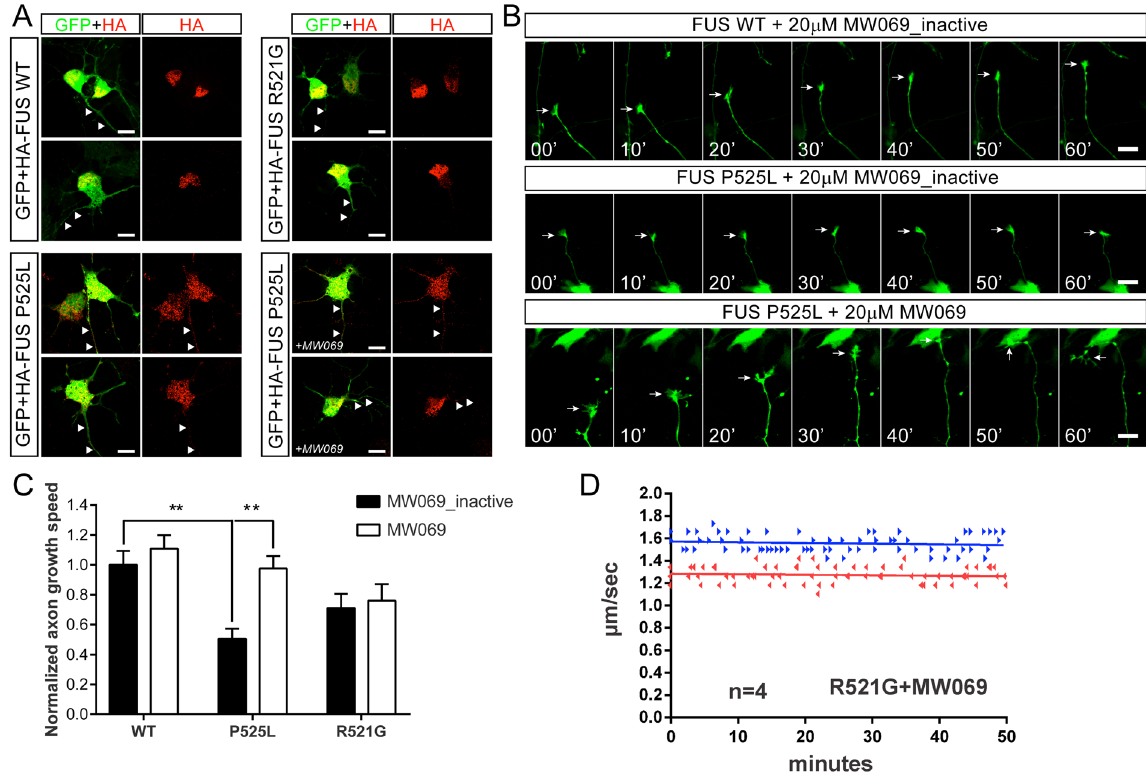
Figure 4. Mutant FUS impairs axon outgrowth in motor neurons through a mechanism involving p38 MAPK activity. Murine motor neurons were transiently co-transfected with FLAGHA-FUS WT, R521G or P525L and green fluorescent protein (GFP) at 2 days in vitro (DIV). Motor neurons were cultured in 20 μ M MW069, a potent and selective p38 MAPK inhibitor, or an inactive analogue, MW069_inactive. ( A ) FUS WT and R521G are predominately expressed within the nucleus of motor neurons, where as FUS P525L is expressed in the nucleus and within axons (white arrowheads). FUS P525L localization is similar whether motor neurons are treated with MW069_inactive or MW069 ( + MW069). ( B ) Montages corresponding to live cell imaging of axon outgrowth (white arrow) over a 60 min time course for the indicated condition. Note that the growth cone of a FUS P525L expressing motor neuron is stalled in the presence of MW069_inactive (middle panel) relative to the active form of MW069 (bottom panel). See Supplemental Video S1 for live cell imaging of all conditions. ( C ) Quantification of axon outgrowth speed compiled from n = 3 biological experiments normalized to the WT + MW069_inactive condition. Statistical significance ( ** p < 0.01) of pertinent comparisons are indicated. Additional significant comparisons include FUS WT + MW069 versus FUS R521G + MW069_inactive (p < 0.05) and FUS WT + MW069 versus FUS P525L + MW069_inactive (p < 0.0001). ( D ) The inhibition of FAT by FUS R521G is blocked by MW069 in squid axoplasm. The motility plot for FUS R521G in the absence of MW069 is shown in Fig.